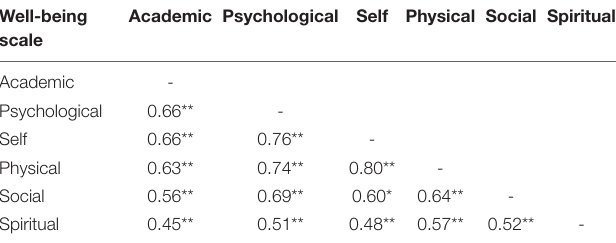
TABLE 4 | Student’s well-being intercorrelations and